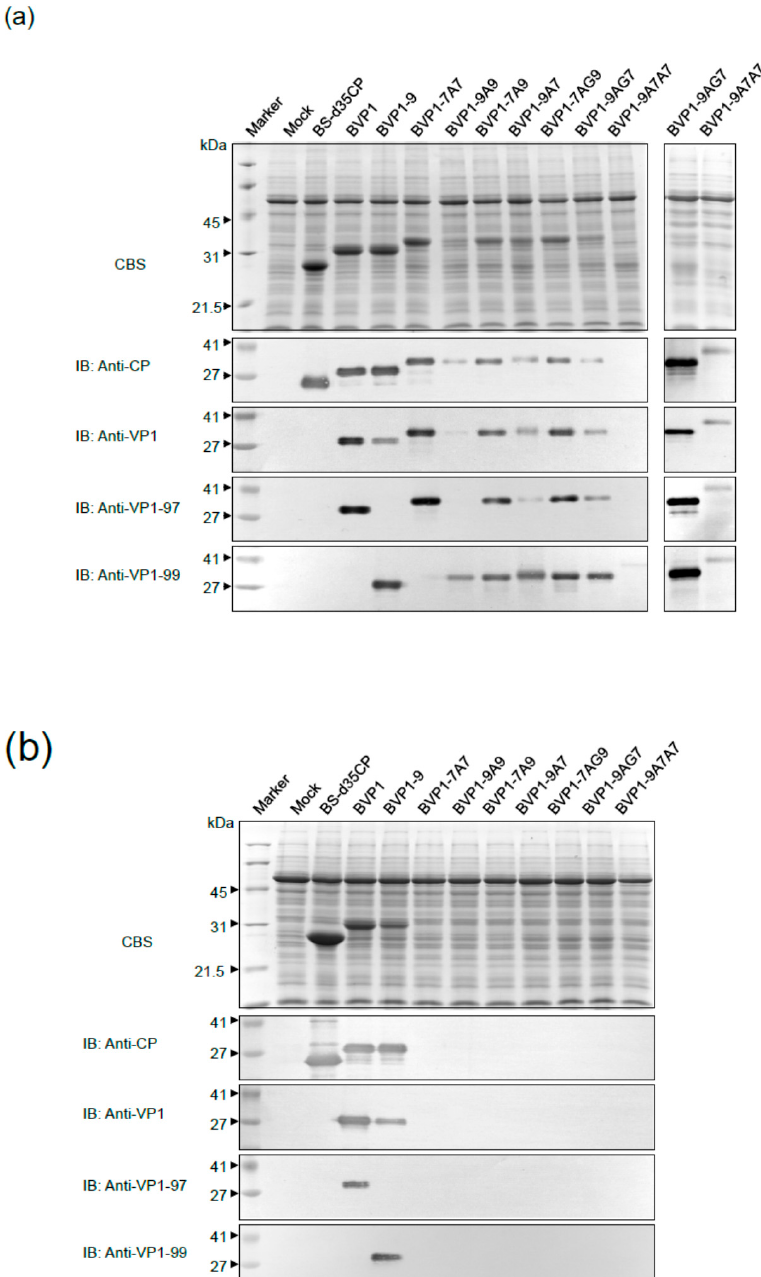
Figure 4. FMDV VP1 epitopes are expressed in N. benthamiana infected with chimeric BaMV. SDS-PAGE separation and immunoblot of proteins extracted from ( a ) inoculated or ( b ) systemically infected N. benthamiana leaves. Leaves were inoculated with H 2 O (mock) or with recombinant plasmid pBS-d35CP, pBVP1, pBVP1-9, pBVP1-7A7, pBVP1-9A9, pBVP1-7A9, pBVP1-9A7, pBVP1-7AG9, pBVP1-9AG7, and pBVP1-9A7A7, as indicated. Total proteins extracted from the inoculated leaves were separated using 12% SDS-PAGE gel (Top panel) and stained with Coomassie Blue stain (CBS). The proteins were transferred to polyvinylidene fluoride membranes and reacted with antisera against BaMV CP (anti-CP), FMDV VP1 (anti-VP1), FMDV VP1 (O/TAW/97 specificity, anti-VP1-97), or FMDV VP1 (O/TAW/99 specificity, anti-VP1-99), respectively. The relative molecular weights (in kDa) are given on the left of each panel. IB, immunoblot.